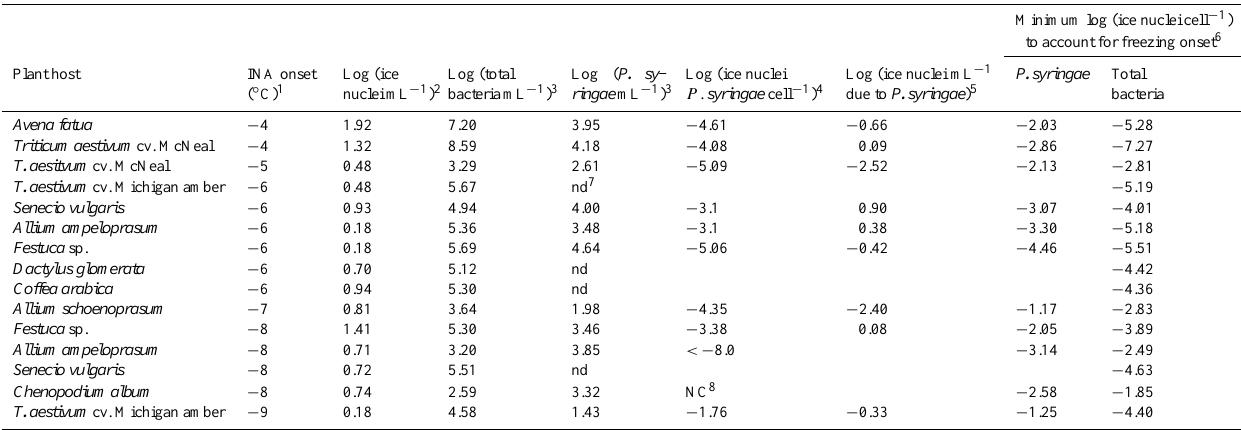
Table 2. Frequency of ice nuclei production required for bacteria to account for the ice nucleation activity observed in suspensions of rust spores.